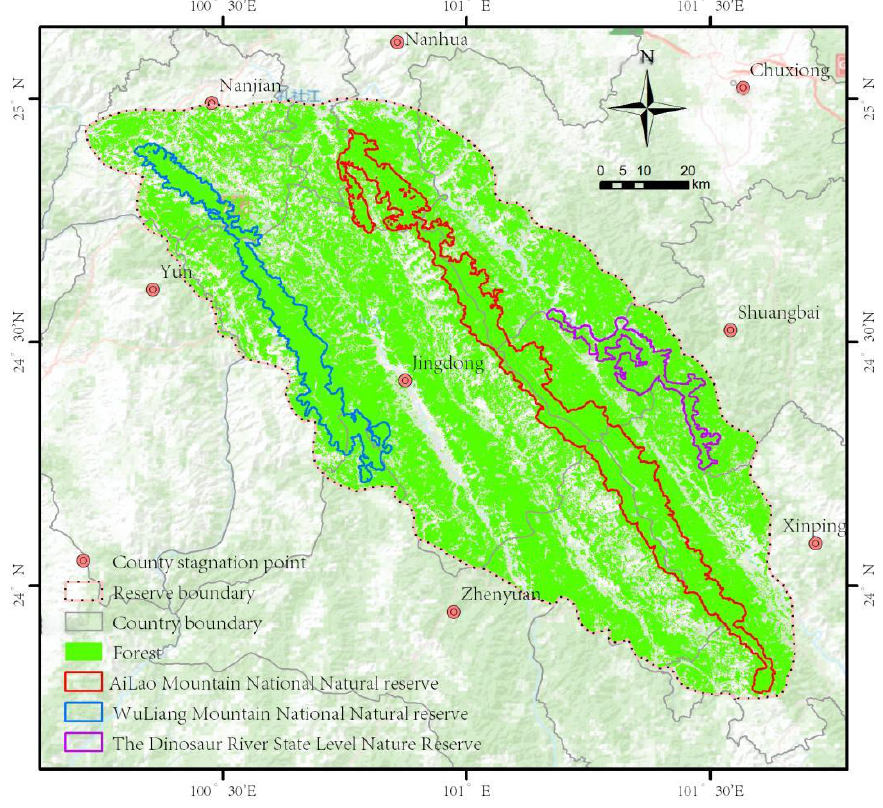
Figure 1. Geographic location map of national parks.